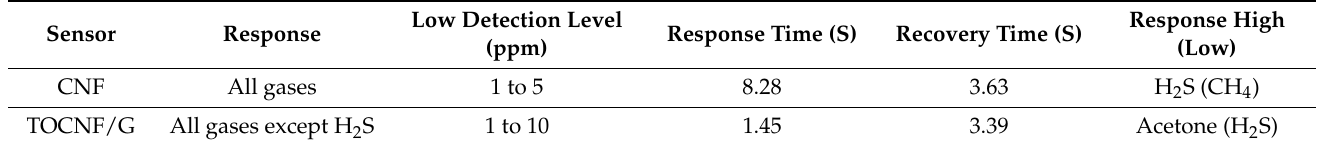
Table 1. Gas sensing performance of the CNF and TOCNF/G